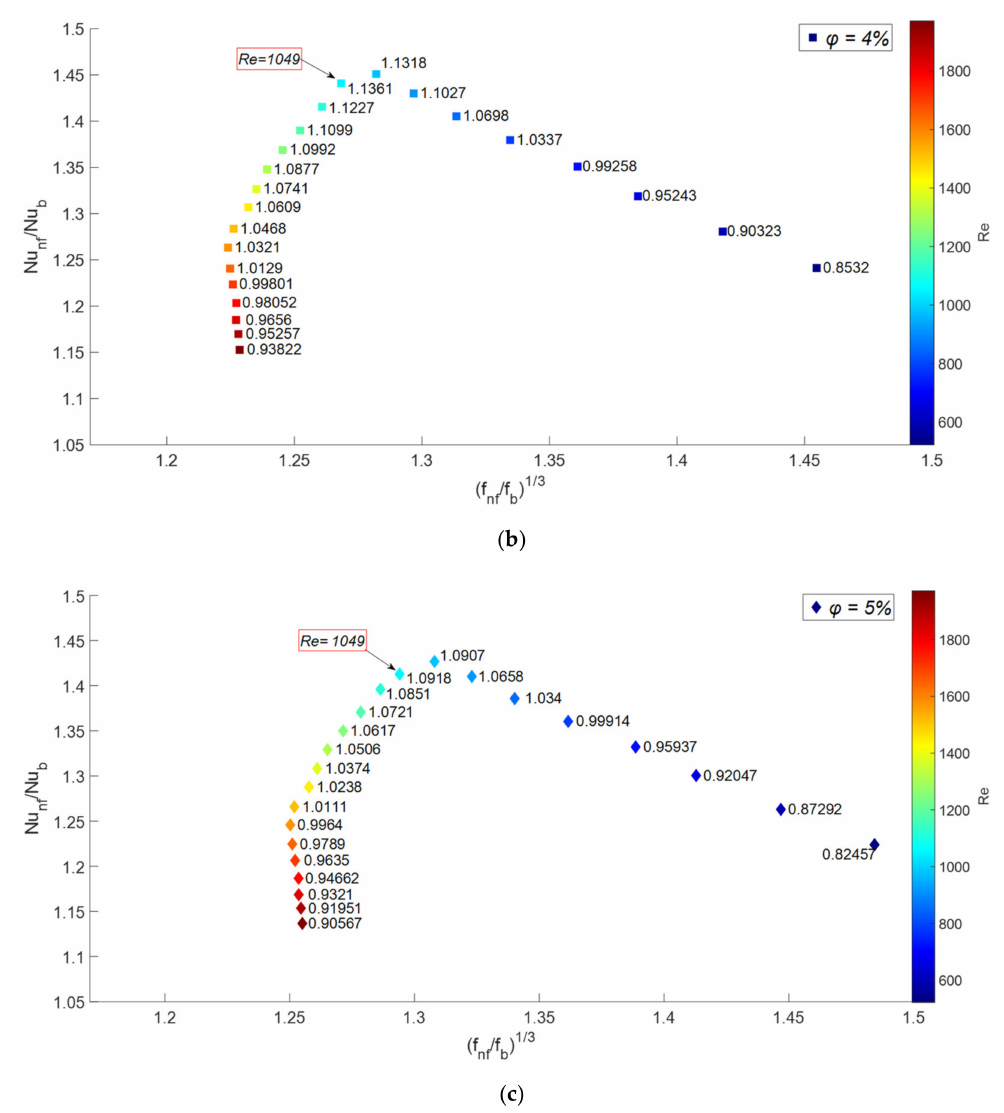
Figure 13. PEC values ( a ) for ϕ = 2%, ( b ) for ϕ = 4% , and ( c ) for ϕ = 5%